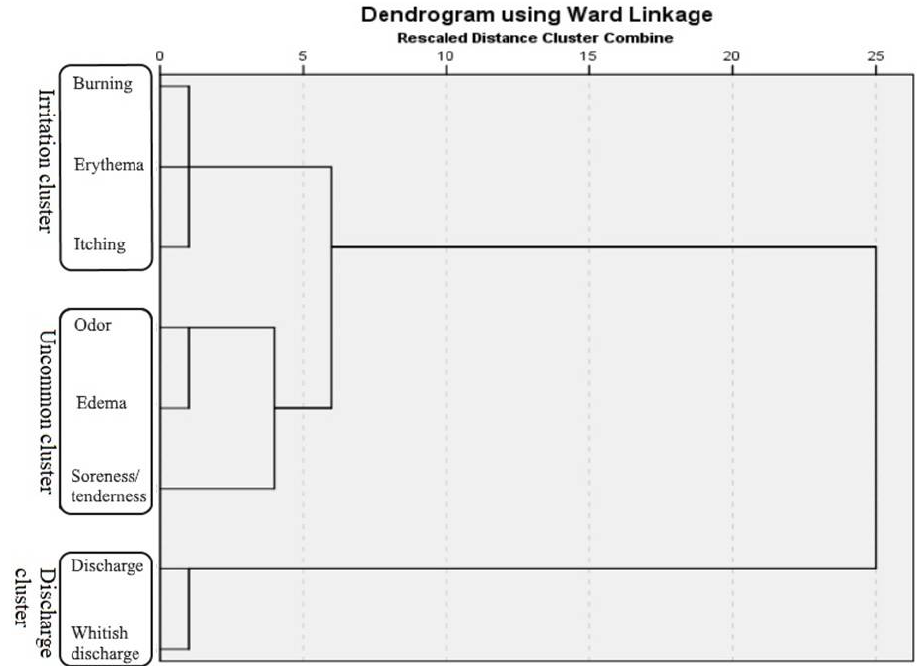
Figure 1. Dendrogram of the recurrent vulvovaginal candidiasis (RVVC) signs and symptoms clusters (Ward method; binary measure—Euclidian distance).